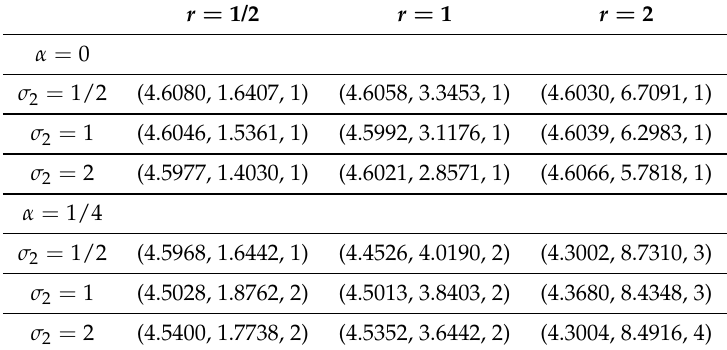
Table 6. Effect of the preferences of DM2 on the payoffs and equilibrium length of the short list in games where σ 1 = 1, ρ 1 = ρ 2 = 2/3 (the first two values in each cell gives the payoffs of the players and the third gives the empirically derived equilibrium length of the short list). When DM1 shows no good will to DM2, then the preferences of DM2 have no effect on the length of the short list. The increase in the expected payoff of DM2 purely reflects the increased variance in the values of the offers to her. When DM1 shows good will, then the equilibrium length of the short list increases as the choosiness of DM2